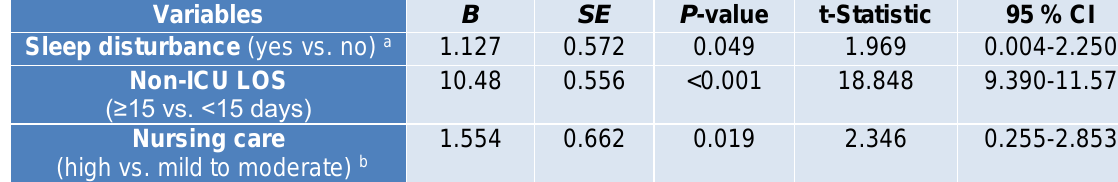
Table 3: Linear regression analysis of influencing factors to predict time incidence of delirium Variables B SE P -value t-Statistic 95 % CI Sleep disturbance (yes vs. no)